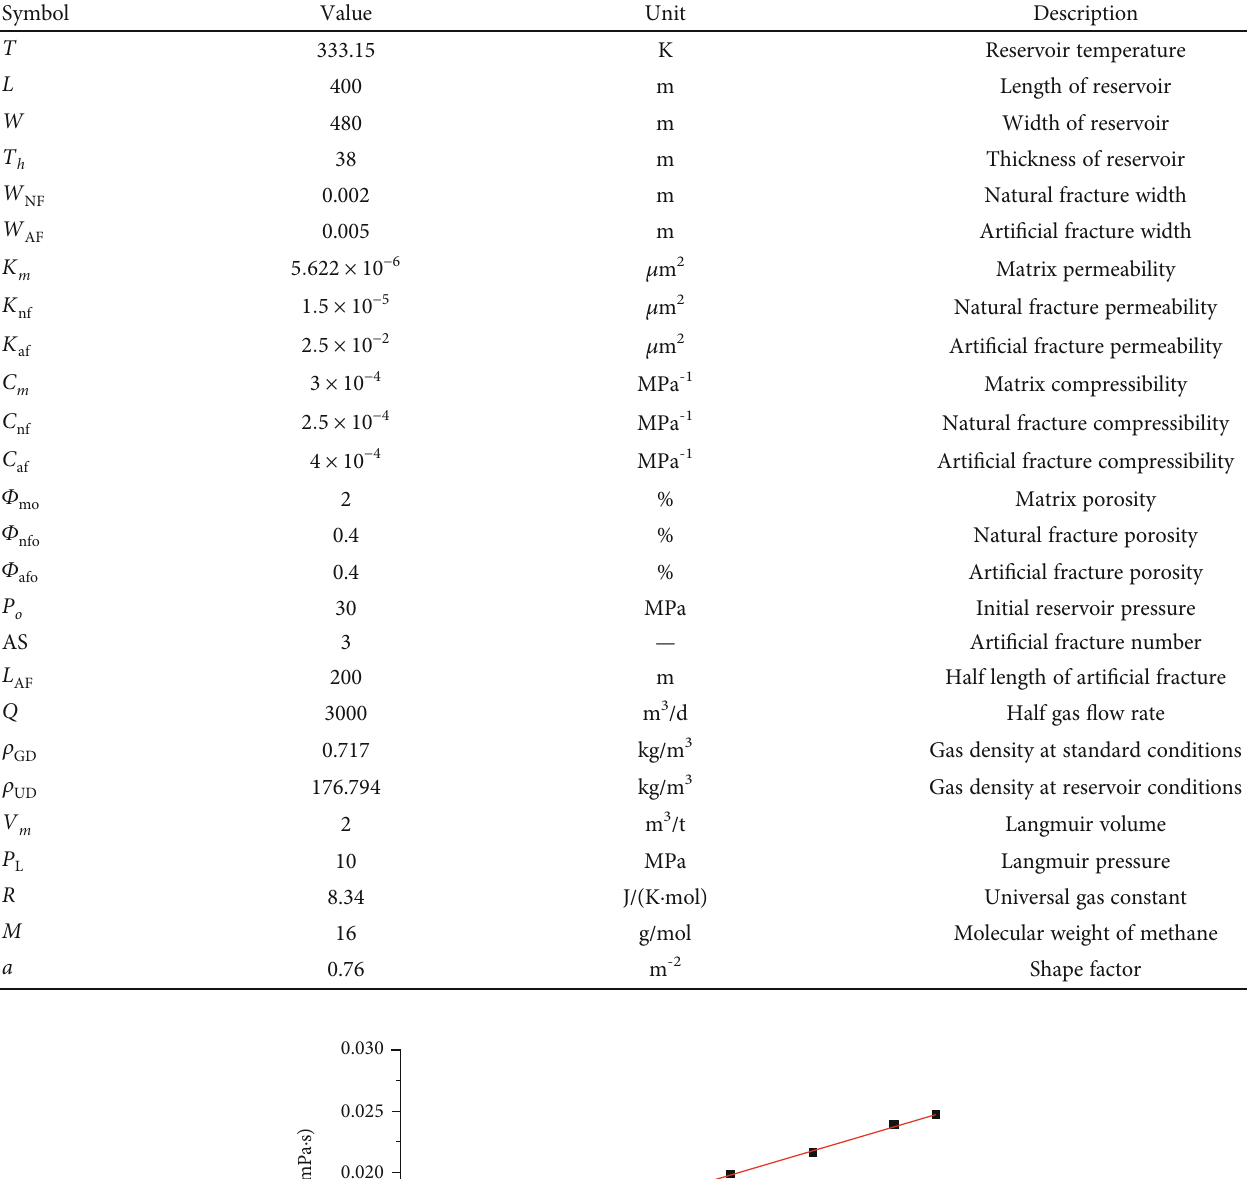
Table 1: Basic parameters of shale reservoir and shale gas [27, 28].